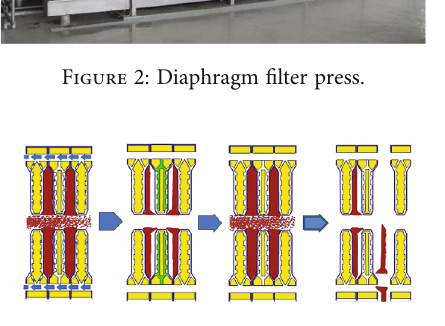
Figure 3: Sludge deep dewatering